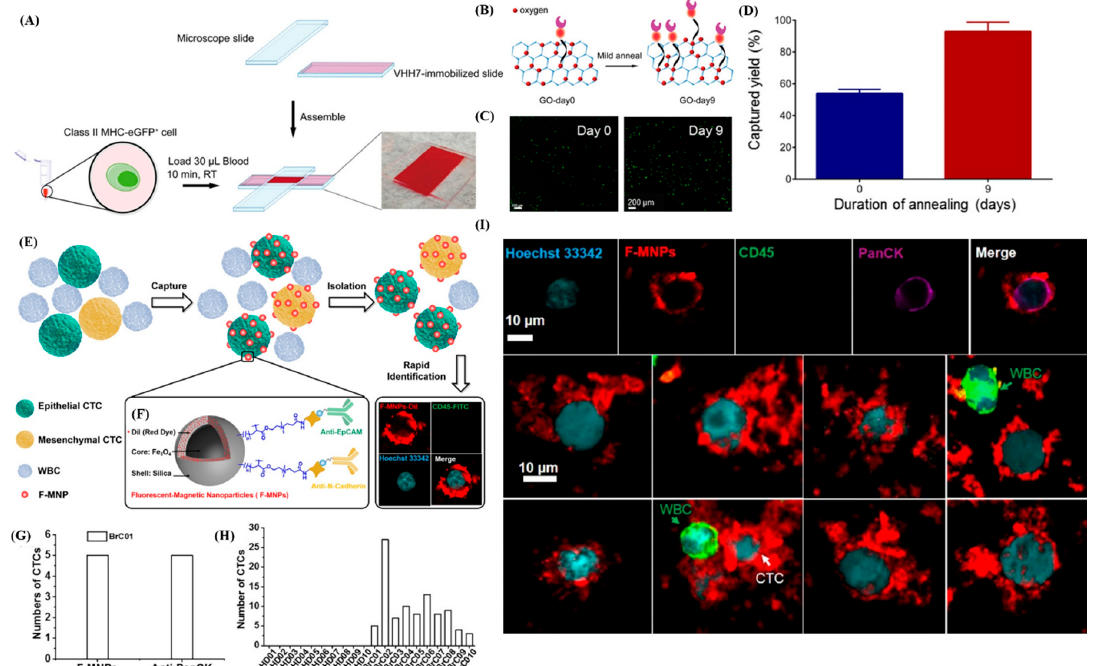
Figure 7. Application of material surface modification methods to diagnostics. ( A ) Schematic of the cell capture device made from glass slides, the assay conditions, and a digital photograph of the constructed and loaded capture chamber. ( B ) Schematic showing enhanced functionalization of GO nanosheets because of oxygen clustering on the graphene basal plane. GO-day 0 represents as-synthesized GO sheets with no annealing treatment, while GO-day 9 represents GO substrates annealed for 9 days at 80 °C to induce oxygen clustering. ( C ) Quantification of captured class II MHC-positive eGFP+ cells from murine whole blood samples comparing Day 0 and Day 9 substrates. ( D ) Cell capture efficiency (92 ± 7%) of annealed GO structure (Day 9) compared to that of as-synthesized structure (Day 0, 54 ± 3%) [100]. ( E ) Schematic for (E) the isolation and rapid identification of heterogeneous CTCs using the F-MNPs and ( F ) the construction as well as chemistry modification of F-MNPs. ( G ) Comparison of identification performance of immunostaining and F-MNPs for the patient sample. ( H ) CTC count of healthy donors and breast cancer patients identified by dual-antibody-modified F-MNPs. ( I ) Fluorescent images of a CTC identified by immunostaining of anti-PanCK-647 as well as F-MNPs and fluorescent images of eight CTCs (Hoechst 33342+, F-MNPs+, CD45 − ) and WBCs (Hoechst 33342+, CD45+) from the patient sample identi fi ed by F-MNPs with immunostaining of anti-CD45-FITC and Hoechst 33342 [103].